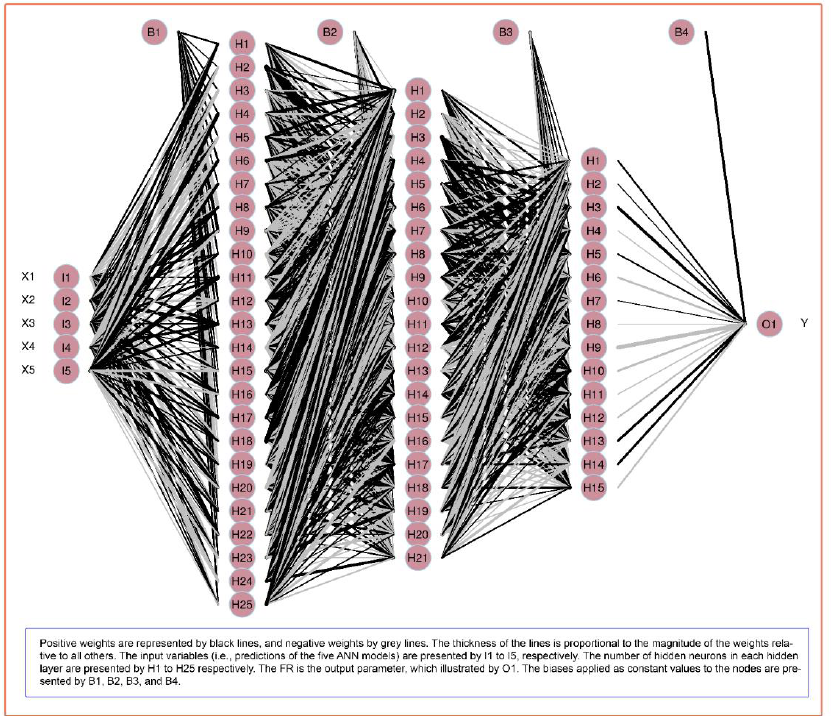
Figure 7. The proposed EANNs model (ensemble of the ANN models) for estimating FR.